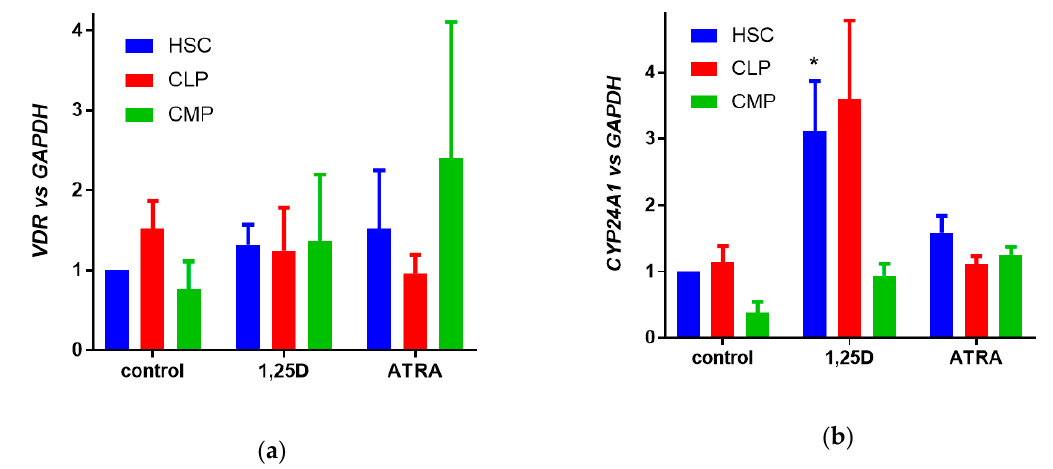
Figure 2. Gene expression in human hematopoietic cells. HSCs, CLPs, and CMPs were sorted from human UCB and then exposed for 96 h to either 10 nM 1,25D or 1 µ M ATRA. The expression of VDR ( a ) or CYP24A1 ( b ) was measured by real-time PCR. The bars represent mean values ( ± SEM) of the fold changes in mRNA levels relative to GAPDH mRNA levels obtained in three experiments. Expression in control HSCs (exposed to vehicle) was treated as a calibrator. Value significantly di ff erent from this obtained from respective control cells is marked with an asterisk (* p < 0.05).